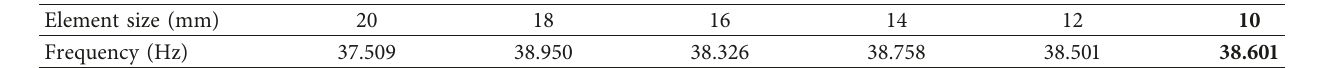
Figure 5: Natural frequency and mode shape results from the in-plane linearized model. (a) Mode 1st, (b) mode 2nd, (c) mode 3rd, (d) mode 4th, (e) mode 5th, (f) mode 6th, (g) mode 7th, and (h) mode 8th. Table 2: Convergence of bending natural frequency with element size